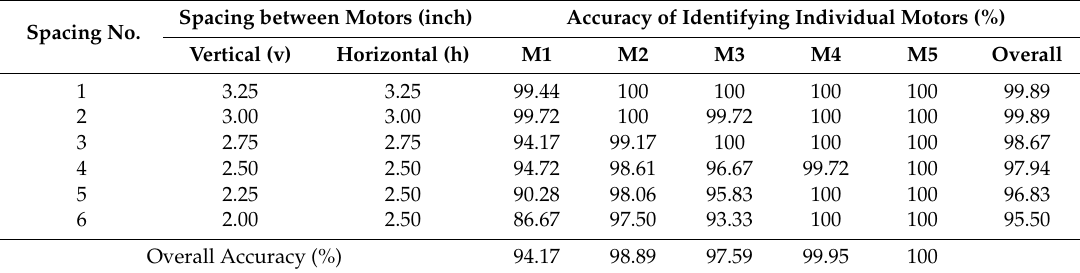
Table 2. Summary of perception accuracy in spacing